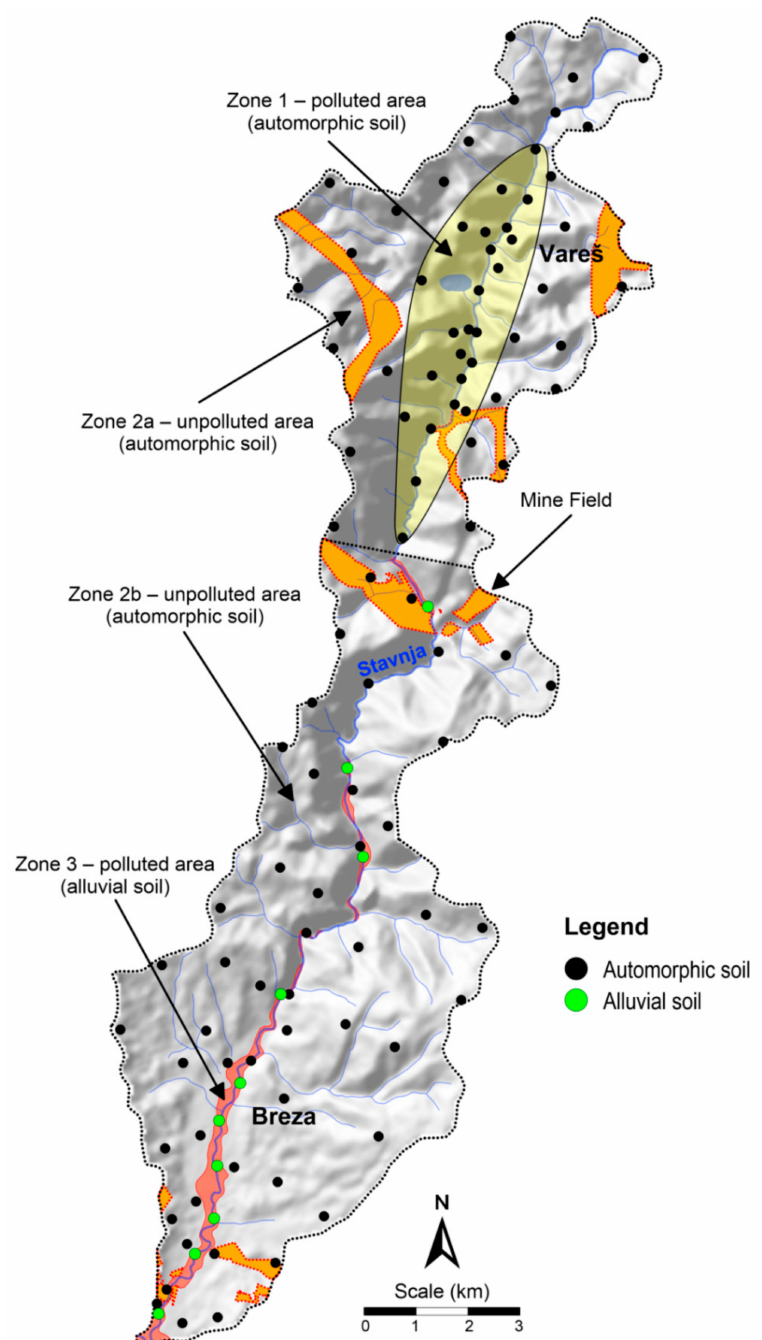
Figure 2. Sampling sites with determined